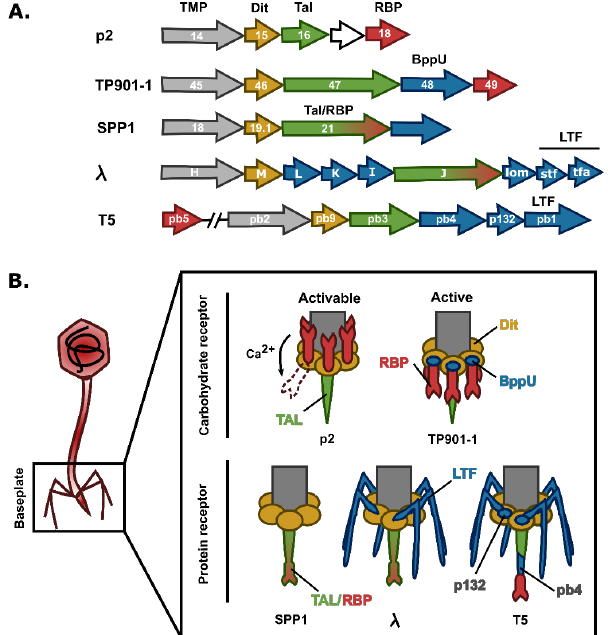
Figure 4. Examples of baseplate organizations found in siphoviruses. ( A ) Tail proteins are usually encoded between the TMP and the lysis cassette (not shown here). Gene identification is indicated in each arrow. TMP are shown in gray, Dit in yellow, Tal in green, RBP in red, other tail proteins in blue, and hypothetical proteins in white. ( B ) Schematic representation of p2, TP901-1, SPP1, λ , and T5 baseplates recognizing either carbohydrate or protein receptors. Color coding is that of the panel ( A ). TMP: Tape Measure Protein; Dit: Distal tail; Tal: Tail lysin; LTF: Long Tail Fiber; BppU: Upper Baseplate protein. This figure was made with Inkscape.